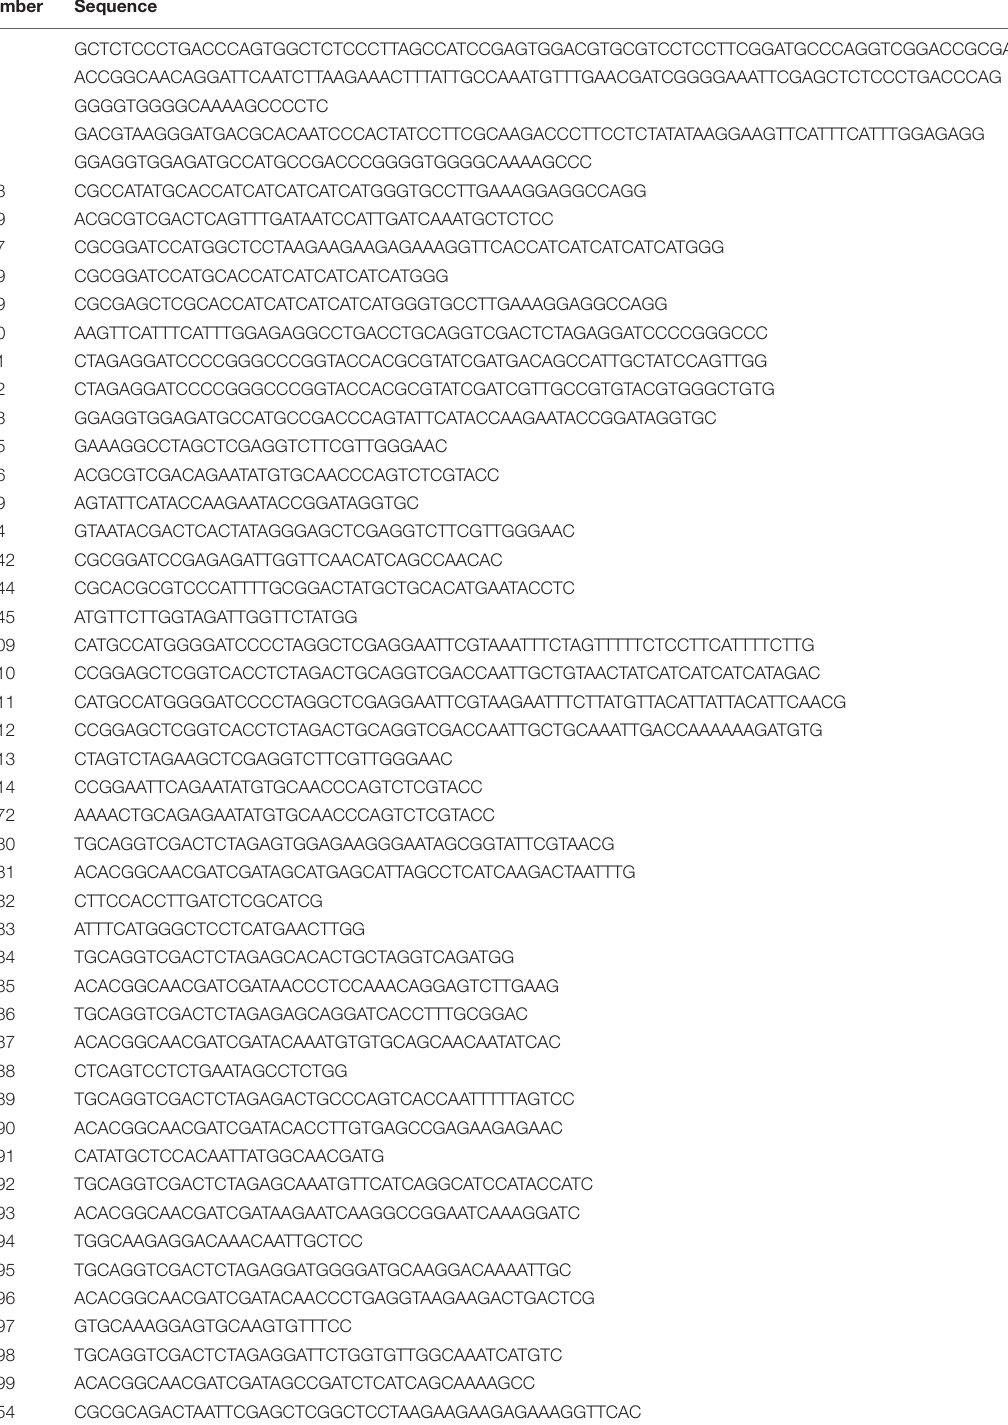
TABLE 1 | Primers used in this